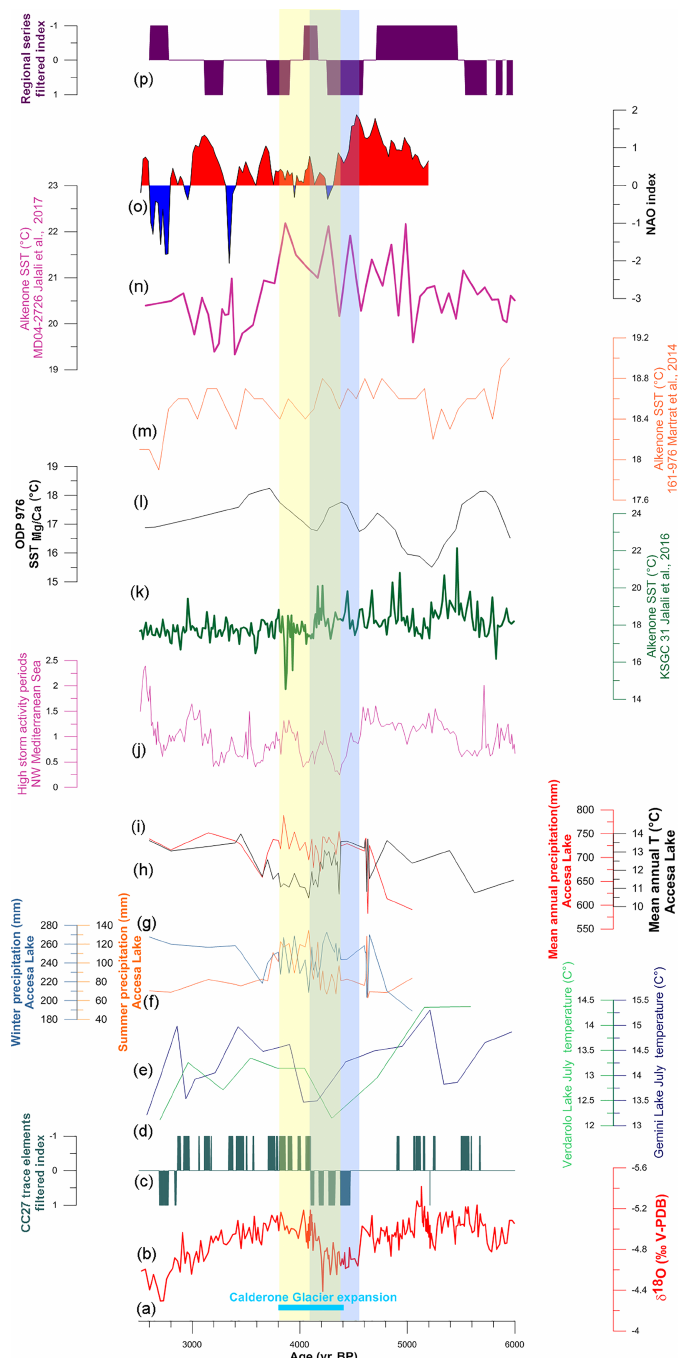
Figure 6. CC27 δ 18 O and trace element mean anomaly filtered index records compared with paleoclimate regional proxies. From bot- tom: (a) Calderone Glacier reactivation (Zanchetta et al., 2012); (b) CC27 δ 18 O; (c) CC27 trace element mean anomaly filtered index; (d) chironomid midge assemblage temperature derived from Verdarolo Lake fossil (Samartin et al., 2017); (e) chironomid midge assemblage temperature derived from Gemini Lake fossil (Samartin et al., 2017); (f) Accesa Lake summer precipitation (Peyron et al., 2013); (g) Accesa Lake winter precipitation (Peyron et al., 2013); (h) Accesa Lake mean annual temperature (Peyron et al., 2013); (i) Accesa Lake mean annual precipitation (Peyron et al., 2013); (j) Gulf of Lions storm activity record (Sabatier et al., 2012); (k) alkenone temperature record from Gulf of Lions (Jalali et al., 2016); (l) SST Mg / Ca temperature record from Alboran Sea (Jiménez-Amat and Zahn, 2015); (m) SST alkenone tem- perature record from Alboran Sea (Martrat et al., 2014); (n) SST alkenone temperature record from MD04-2726 in the east Mediterranean (Jalali et al., 2017); (o) NAO index reconstruction (Olsen et al., 2012); (p) mean anomaly filtered index of the regional proxies as discussed in the main